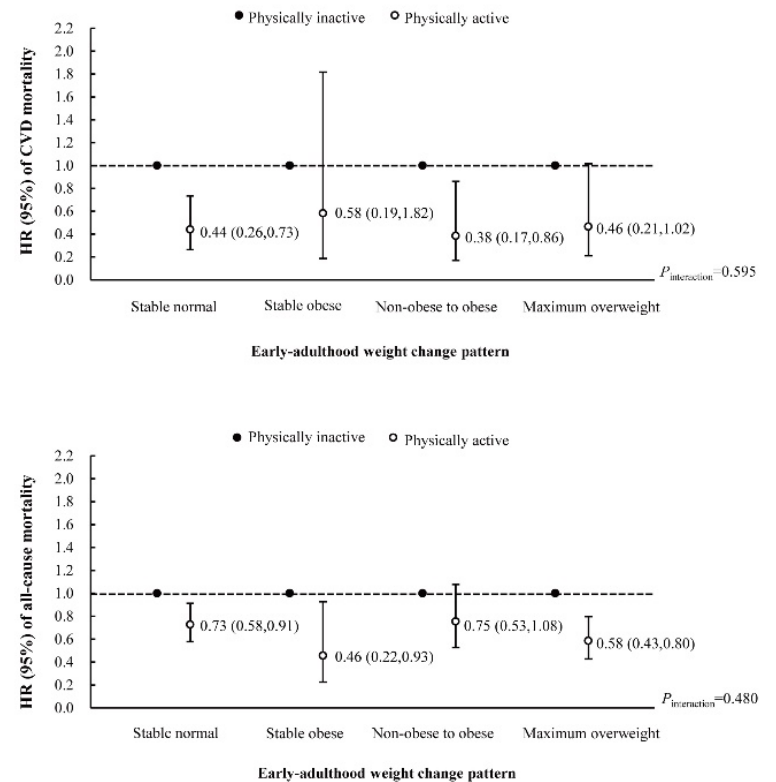
Figure 3. Hazard ratios (95% CIs) of CVD and all-cause mortality according to later physical activity stratified by early-adulthood weight change pattern. Adjusted for age, sex, race/ethnicity, education, family income, baseline BMI, total cholesterol, HDL cholesterol, carbohydrate intake, dietary fiber, protein intake, fat intake, energy intake, alcohol drinking status, smoking status, hypertension and diabetes.